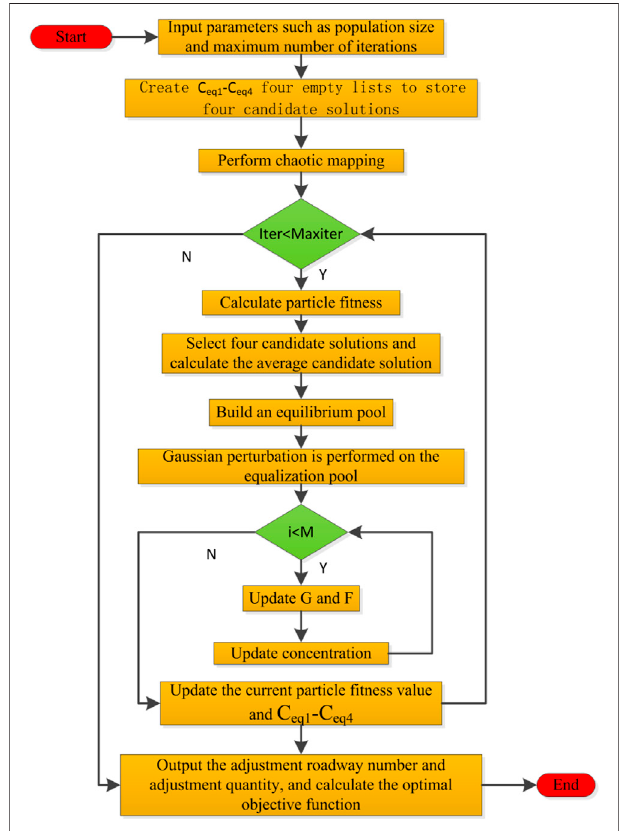
FIGURE5| Flowchartoftheventilation optimizationalgorithmbased on the improved equalization optimizer algorithm.